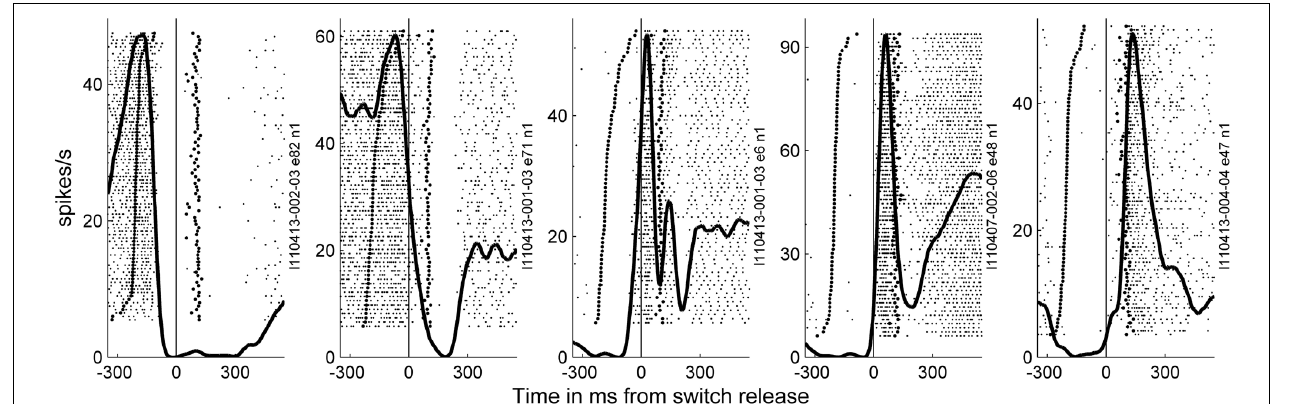
FIGURE 7 | Examples of the activity of neurons recorded during a few of the selected subsessions. Spiking data were aligned to switch release (t0) as the MRPs of the LFP. In the raster displays, each horizontal line corresponds to a trial, and each small dot to the occurrence of a spike.Trials were aligned according to increasing reaction times. In each example, the data recorded during 59–82 trials during SG–HF are shown.The first raw of